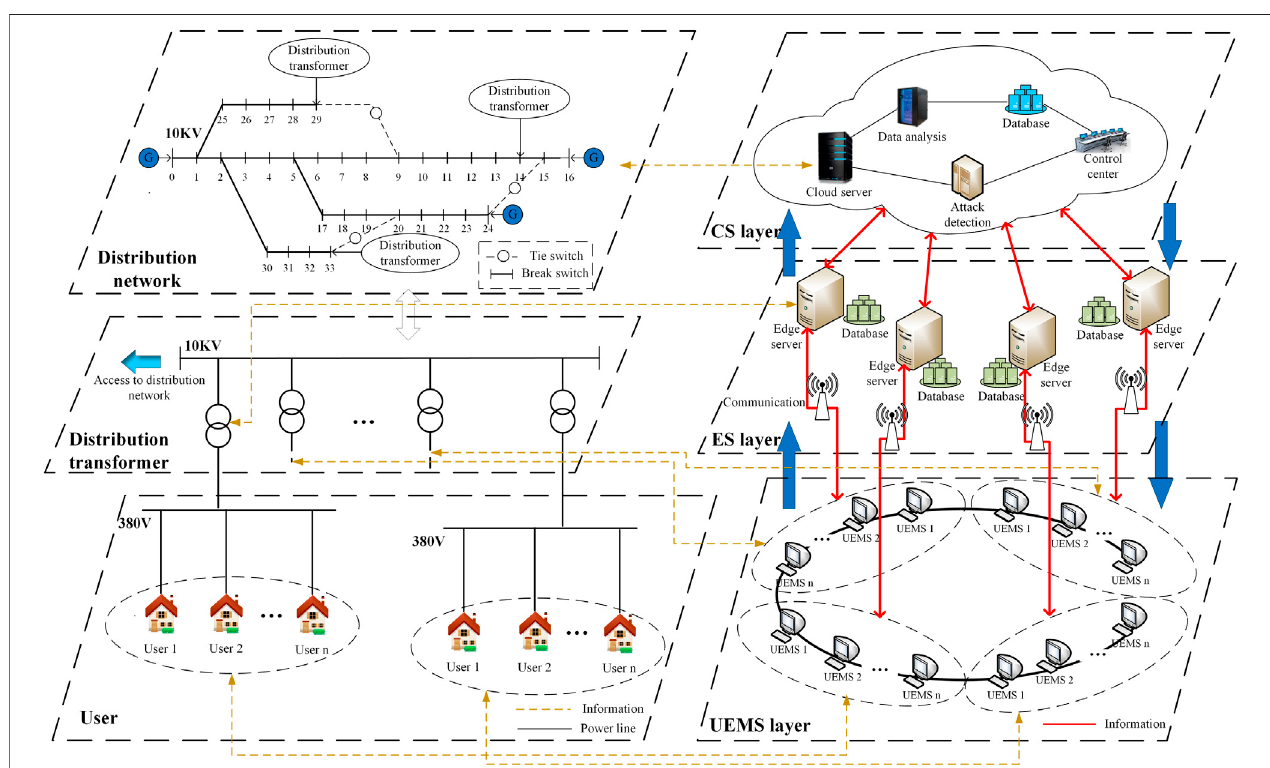
FIGURE1| ECCRFcontainsthephysical fi eldandcyber fi eld.TheECtechnologyisimplementedinEStoprovideLF,whiletheCCisusedinCStoreconstructtheDN.